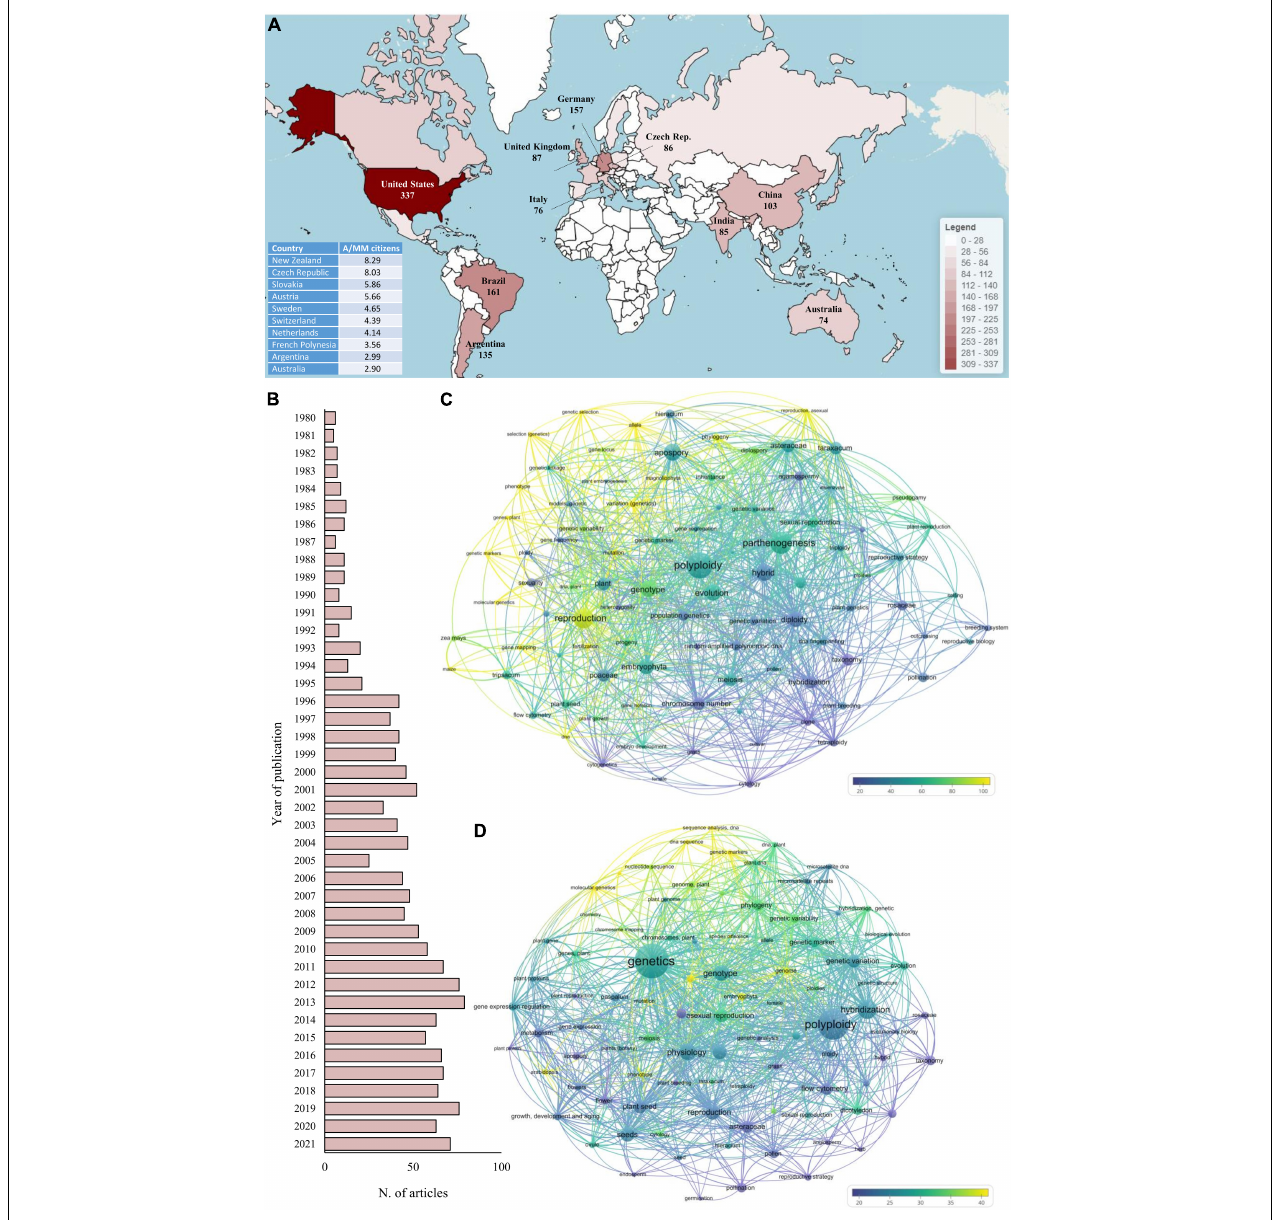
FIGURE 1 | Bibliometric analysis of the studies related to apomixis retrieved from the Scopus database, where the search was limited to articles published in English-based journals between 1980 and 2021. The search of the term “apomixis” was limited to the title, abstract and keywords. (A) The 10 countries with the highest number of contributions (in terms of published articles) to apomixis. The bottom left table indicates the top 10 countries with the highest number of articles per million citizens A/MM. (B) Contributions to apomixis by year. (C,D) Co-occurrence network analysis of the 100 most used keywords in apomixis-related articles published in 1980–2000 and 2001–2021, respectively. The font size of each keyword is proportional to the number of times the keyword has been used within the articles considered, while the color scale is based on the average number of citations received by the documents in which each specific keyword